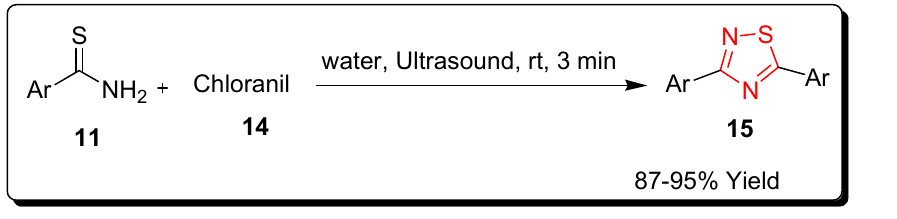
Aryl= -phenyl, 4-methylphenyl, 4-methoxylphenyl, 4- t -Buphenyl, 4-chlorophenyl, 4-flourophenyl, 4-nitrophenyl Scheme 5. Ultrasonic-assisted synthesis of 1,2,4-thiadiazoles 15 . Scheme 5. Ultrasonic-assisted synthesis of 1,2,4-thiadiazoles 15